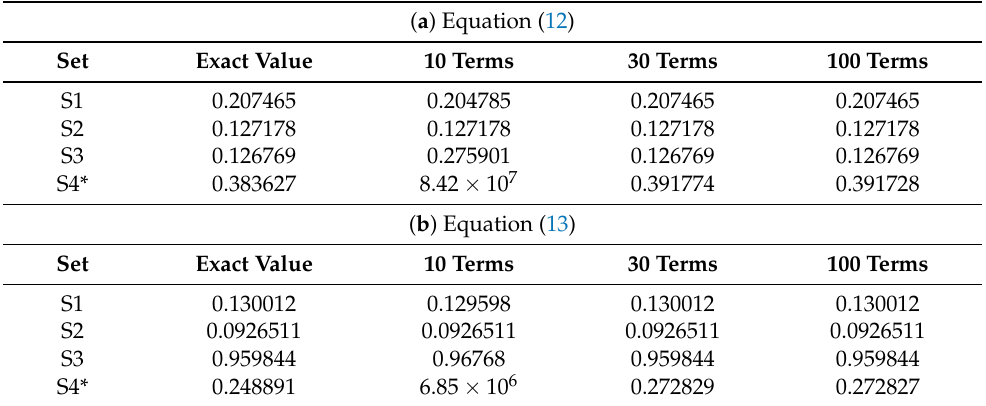
Table 2. Convergence analyses at w =